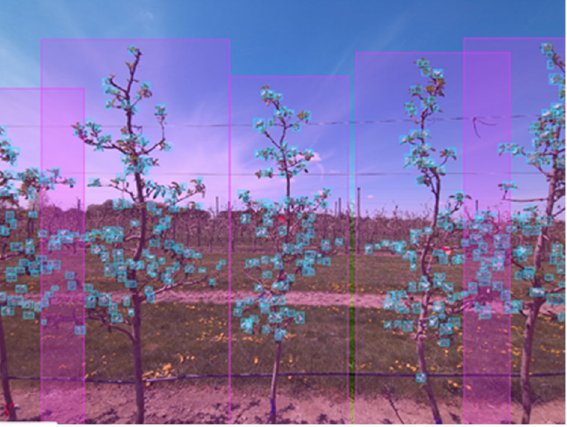
Figure 7. Final iteration of the training dataset with each flower cluster identified (blue boxes), and each corresponding apple tree identified (pink